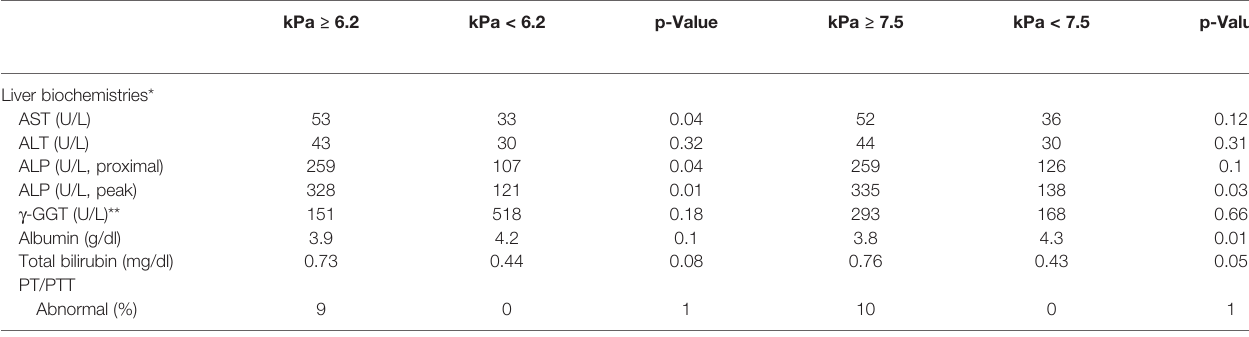
TABLE 3 | Relationship between liver biochemistries and liver stiffness cutoffs for NRH in CVID patients.